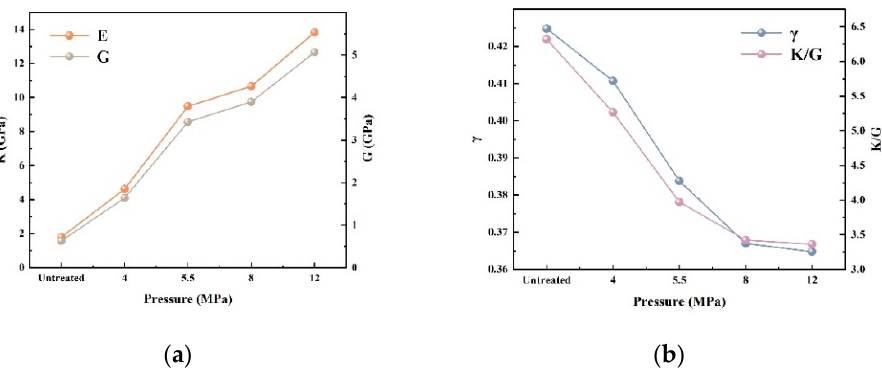
Figure 6. Mechanical parameter of water–cellulose model ( a ) Young’s modulus and shear modulus; ( b ) Poisson’s ratio and the ratio of volume variable to shear variable.